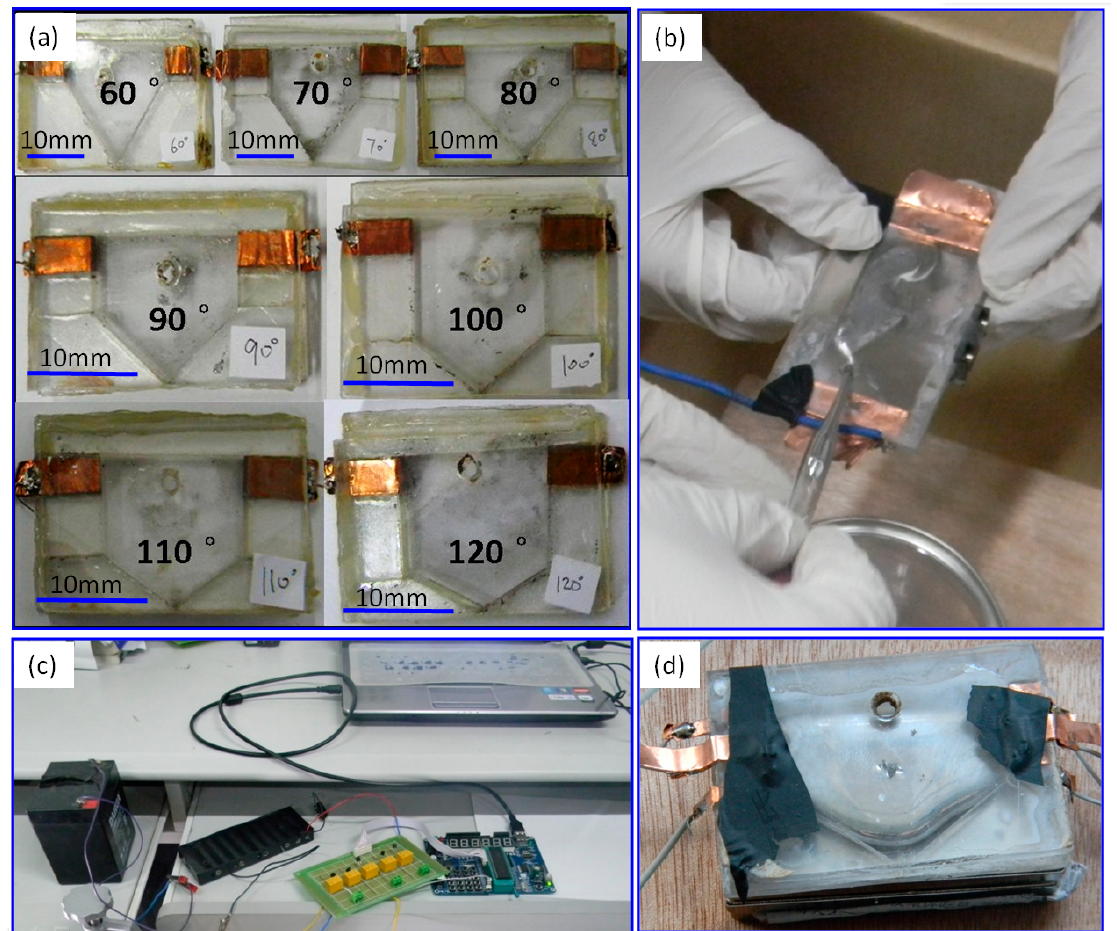
Figure 3. ( a ) Fabricated prototypes of jetting valves with different lead angles ( θ ). ( b ) Filling gallium into the valve with a dropper. ( c ) The controller and the power source. ( d ) The jetting valve loaded with gallium.